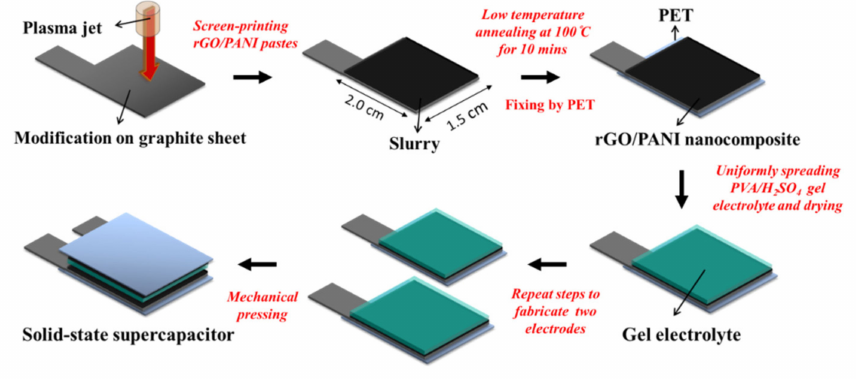
Figure 1. Process flow of atmospheric pressure plasma jet (APPJ)-treated reduced-graphene-oxide / polyaniline (rGO / PANI)